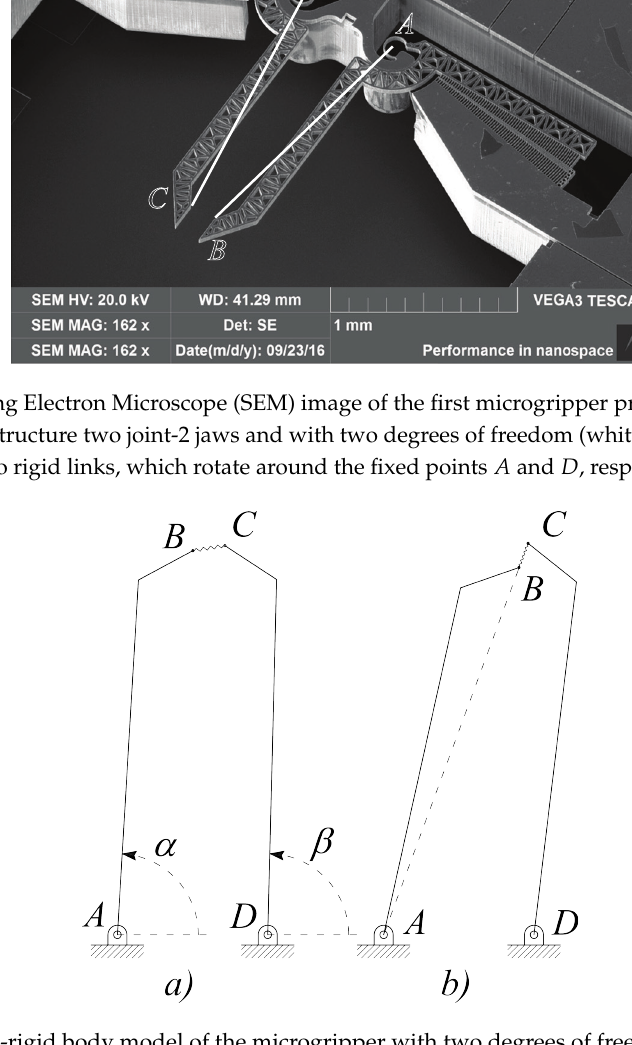
Figure 3. Pseudo-rigid body model of the microgripper with two degrees of freedom in an ordinary ( a ) and a critical ( b )